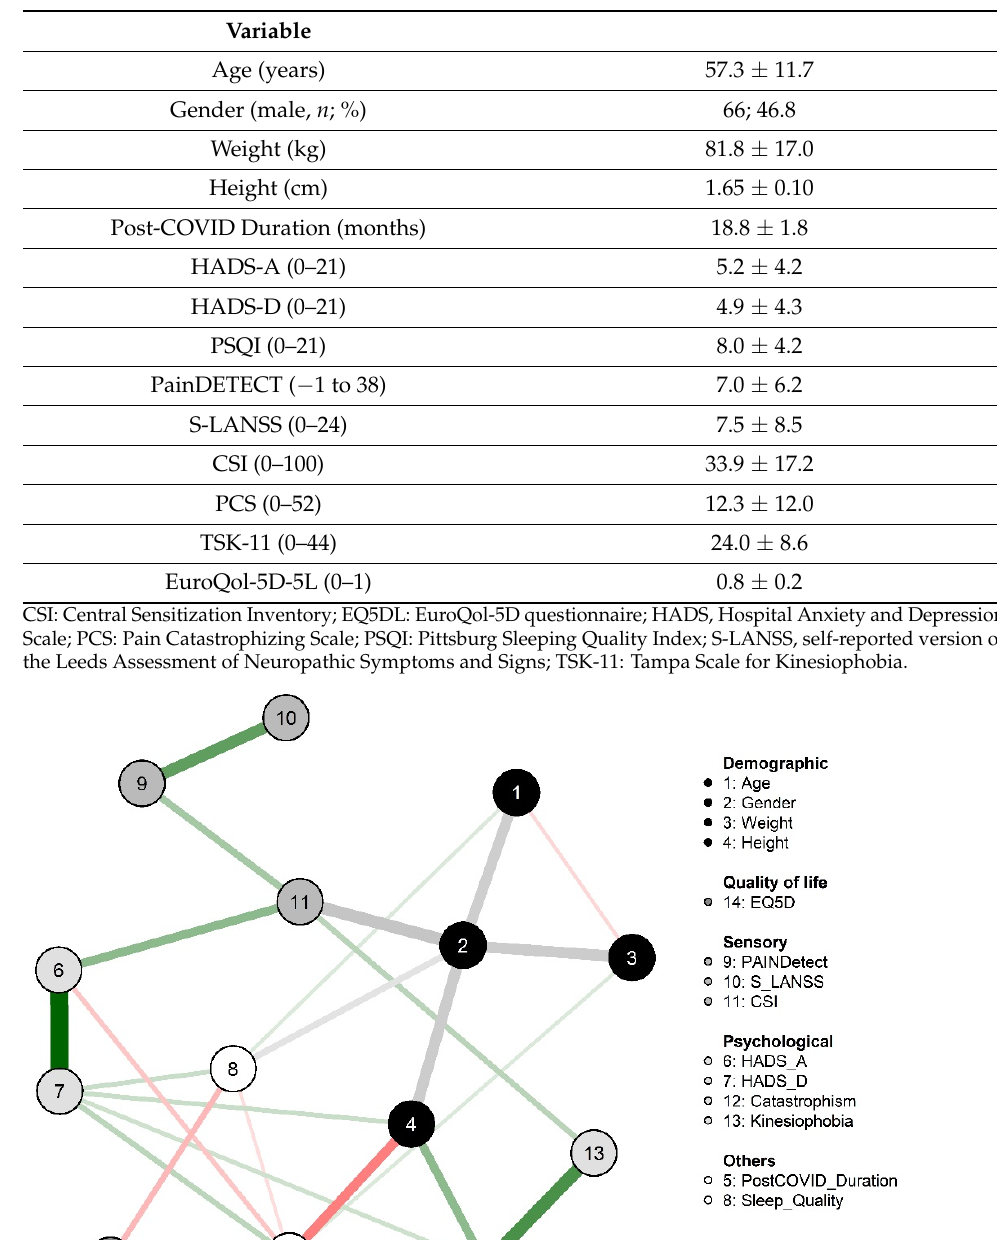
Table 1. Values (mean ± standard deviation) of demographic, quality of life, sensory, psychological and clinical variables of the total sample ( n = 141).